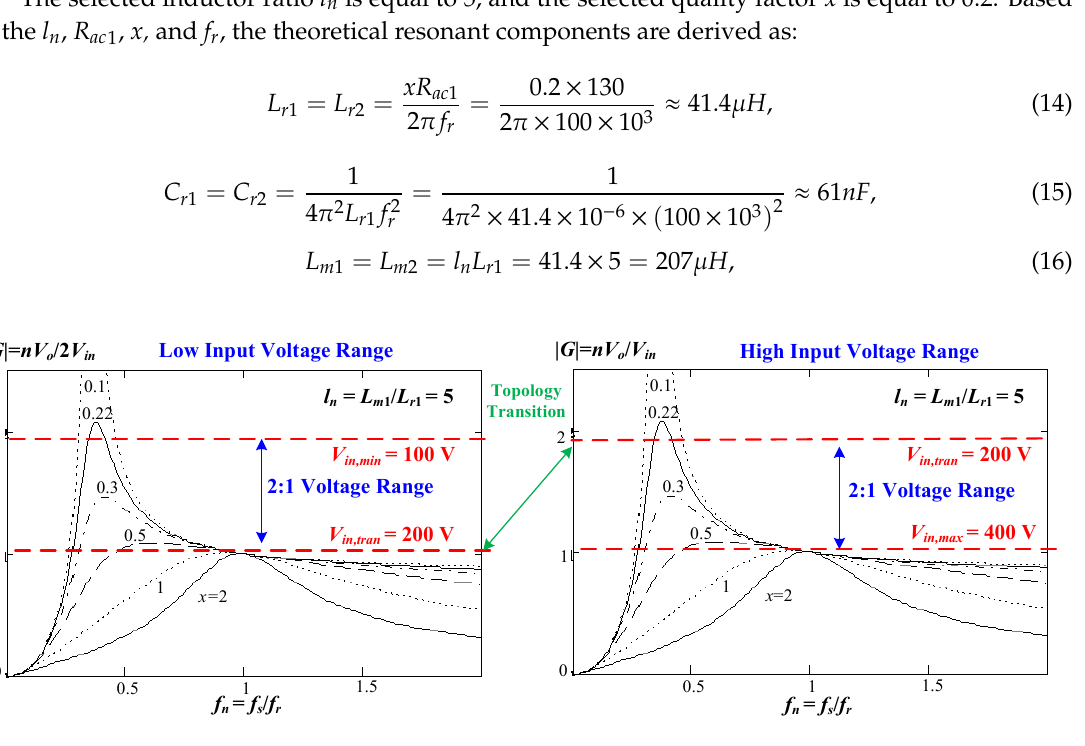
Figure 6. Voltage gain of the studied circuit for V in 100 V ~ 400 V and V o = 400 V.